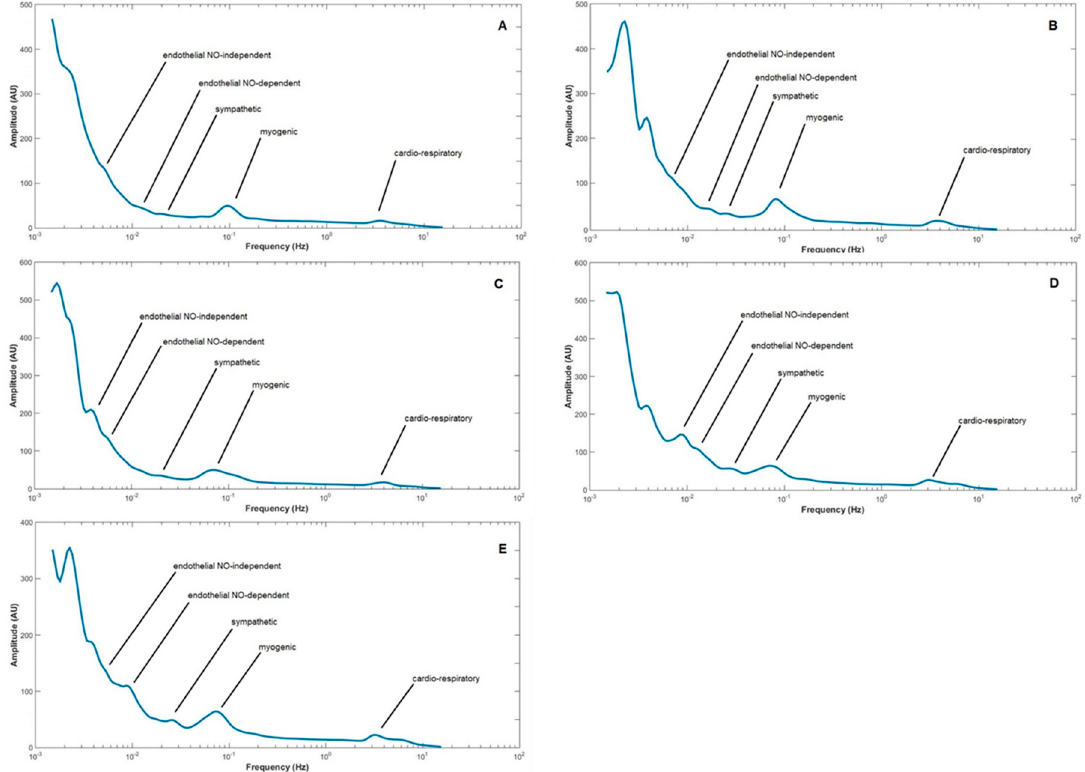
Figure 2. Mean power spectrum of the laser Doppler flowmetry (LDF) signal constructed for each group—Control ( A , n = 8), db /+ ( B , n = 8), db / db ( C , n = 8), NHE1-WT ( D , n = 8) and NHE1-OE ( E , n = 9) from all perfusion mean values obtained during the complete protocol.